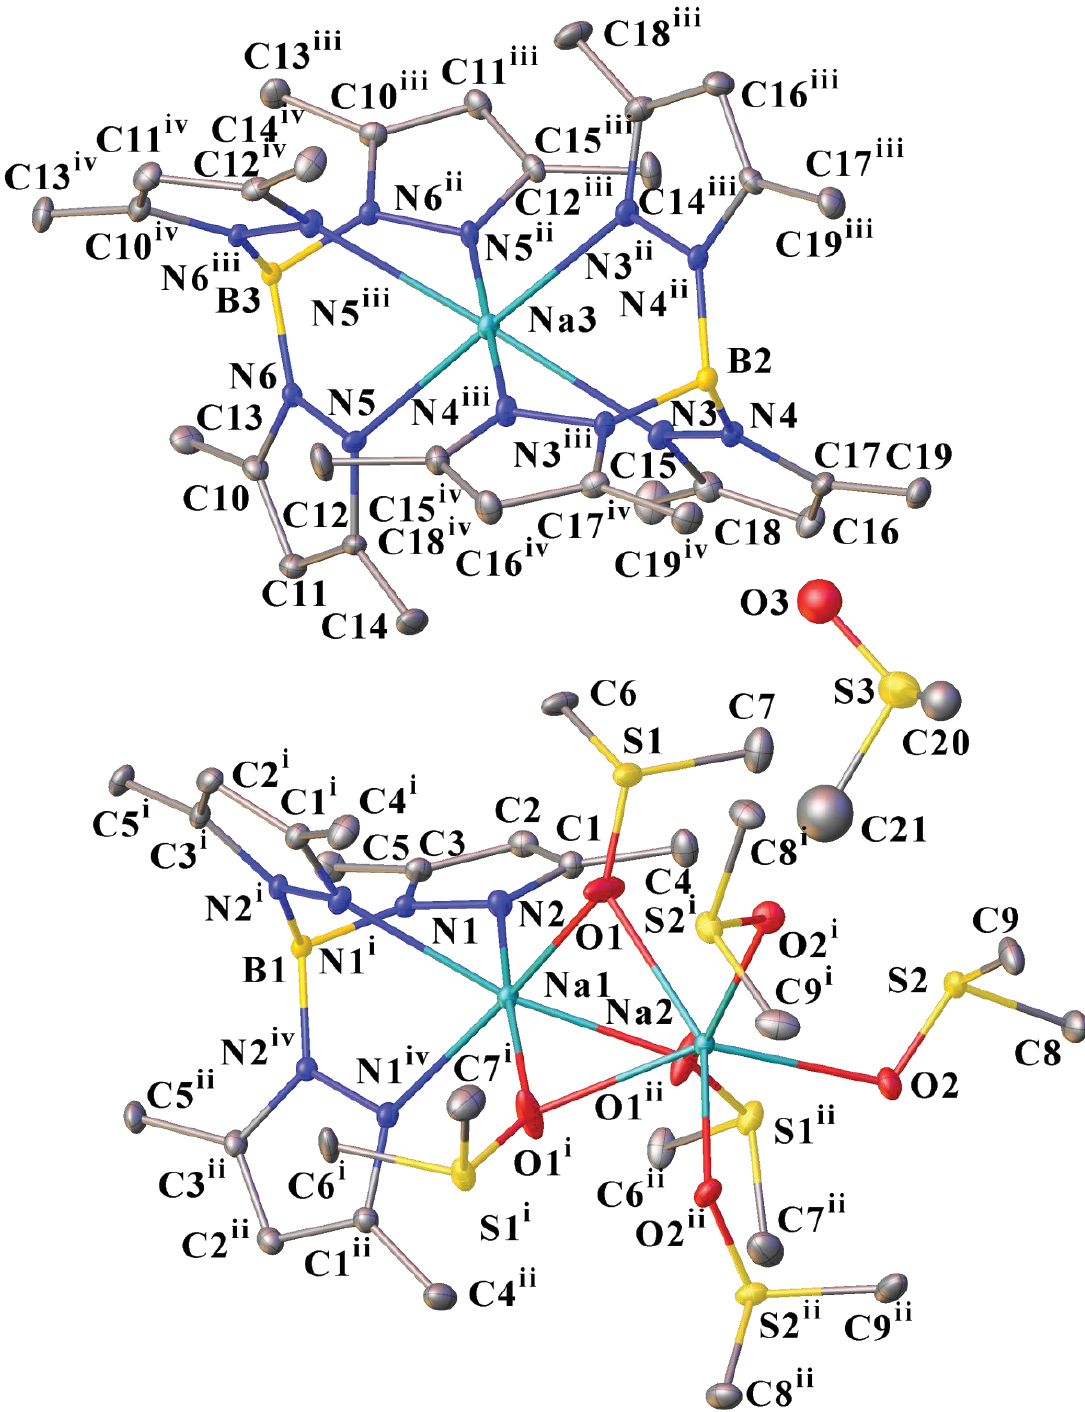
Figure 4: Ortep view of the molecular structure of [Na (hydrogen atoms are omitted for clarity) (B yellow, N blue, O red, S yellow, C grey, Na turquoise). Selected bond lengths (Å) and angles (deg) with estimated standard deviations in parentheses: B1–N2 1.552(3), B2–N4 1.541(3), B3–N6 1.538(3), Na1–N1 2.459(3), Na3–N3